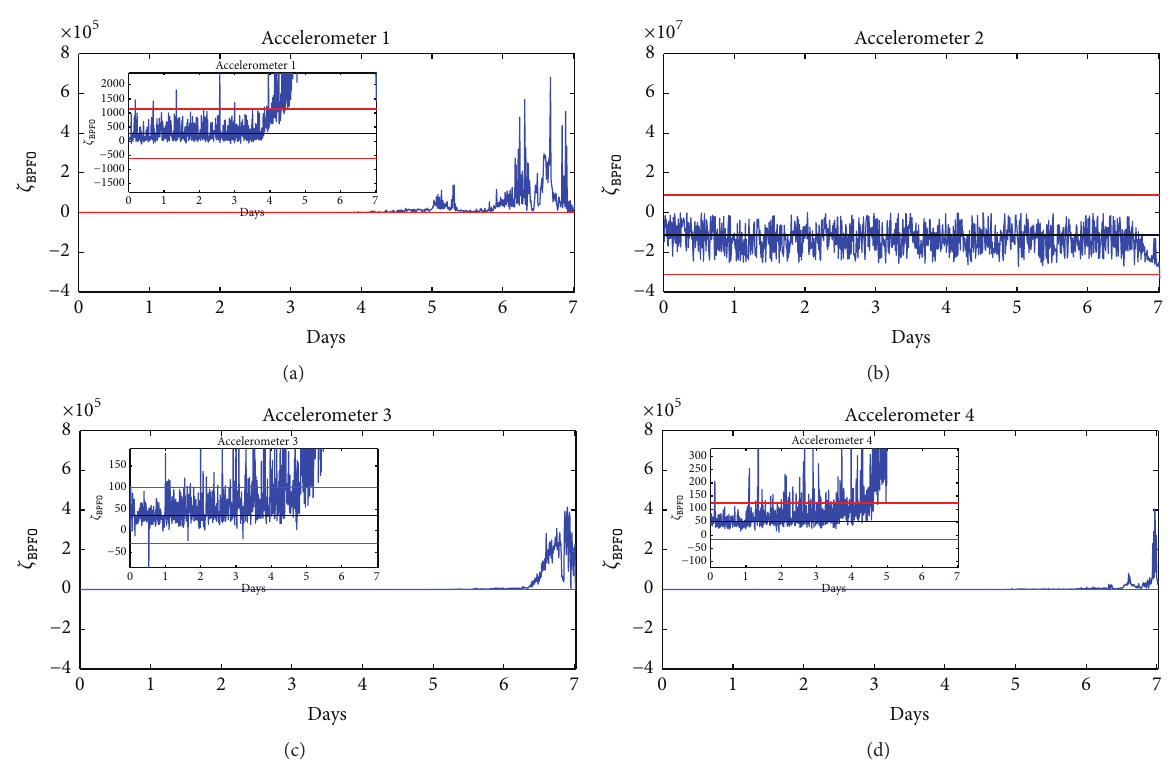
Figure 11: Damage indicators associated with the BPFO frequency from each